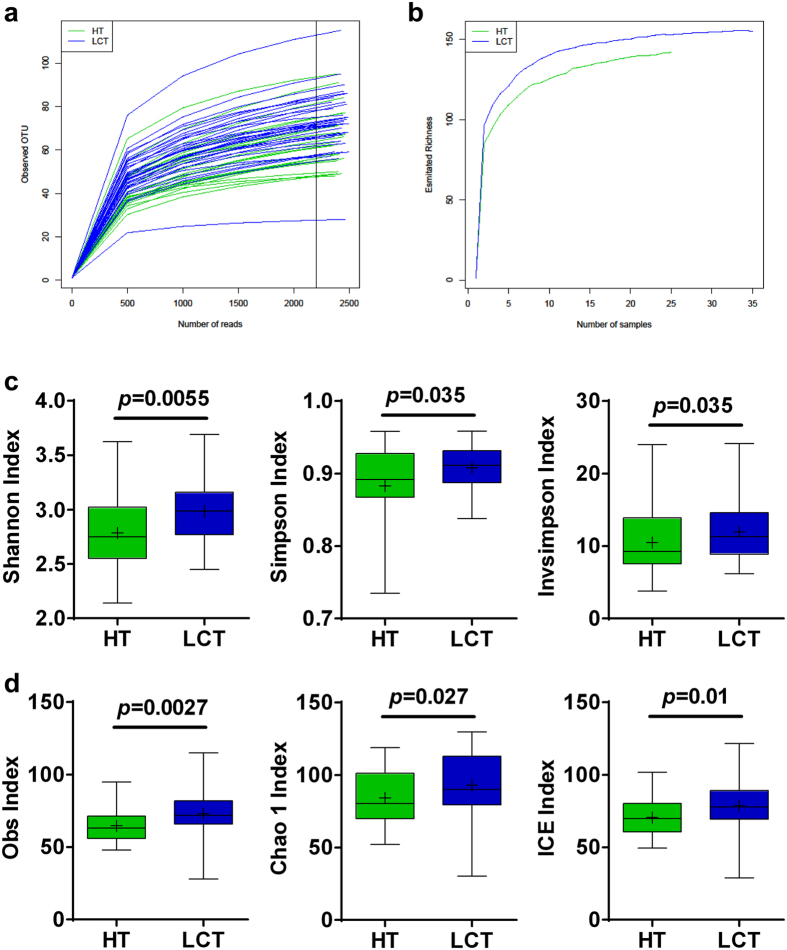
Phylogenetic diversity of tongue coat microbiomes among individuals and between LC patients and healthy subjects.(a) Rarefaction analysis of bacterial 16S rRNA gene sequences was used to evaluate if further sequencing would likely detect additional taxa, indicated by a plateau; (b) Richness index curves that evaluate the number of samples likely required to identify additional taxa indicated by a plateau; (c) Box plots depict microbiomes diversity differences according to the Shannon index, Simpson index and invsimpson index between the LCT and HT; (d) Box plots depict microbiomes diversity differences according to the Obs index, Chao 1 index and ICE index between LCT and HT. Box parameters, the “+” symbol represents median value, and the upper and lower ranges of the box represent the 75% and 25% quartiles, respectively. LCT, liver cancer patients tongue coat; HT, healthy subjects tongue coat.